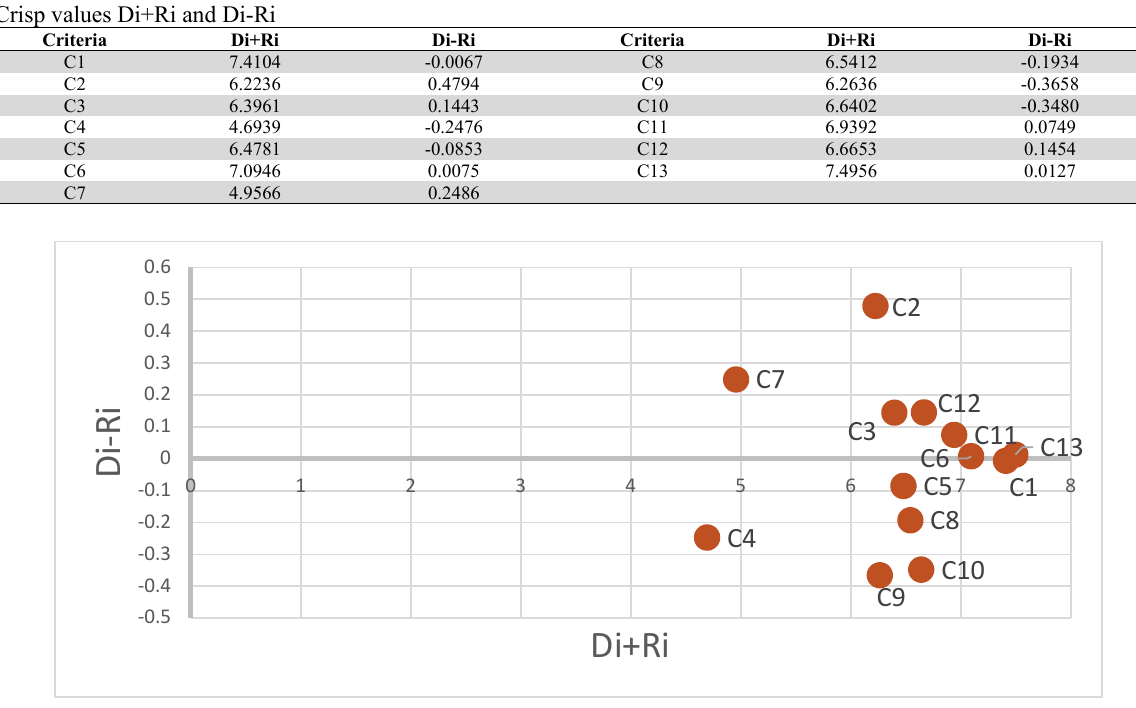
Fig. 3. Cause and effect